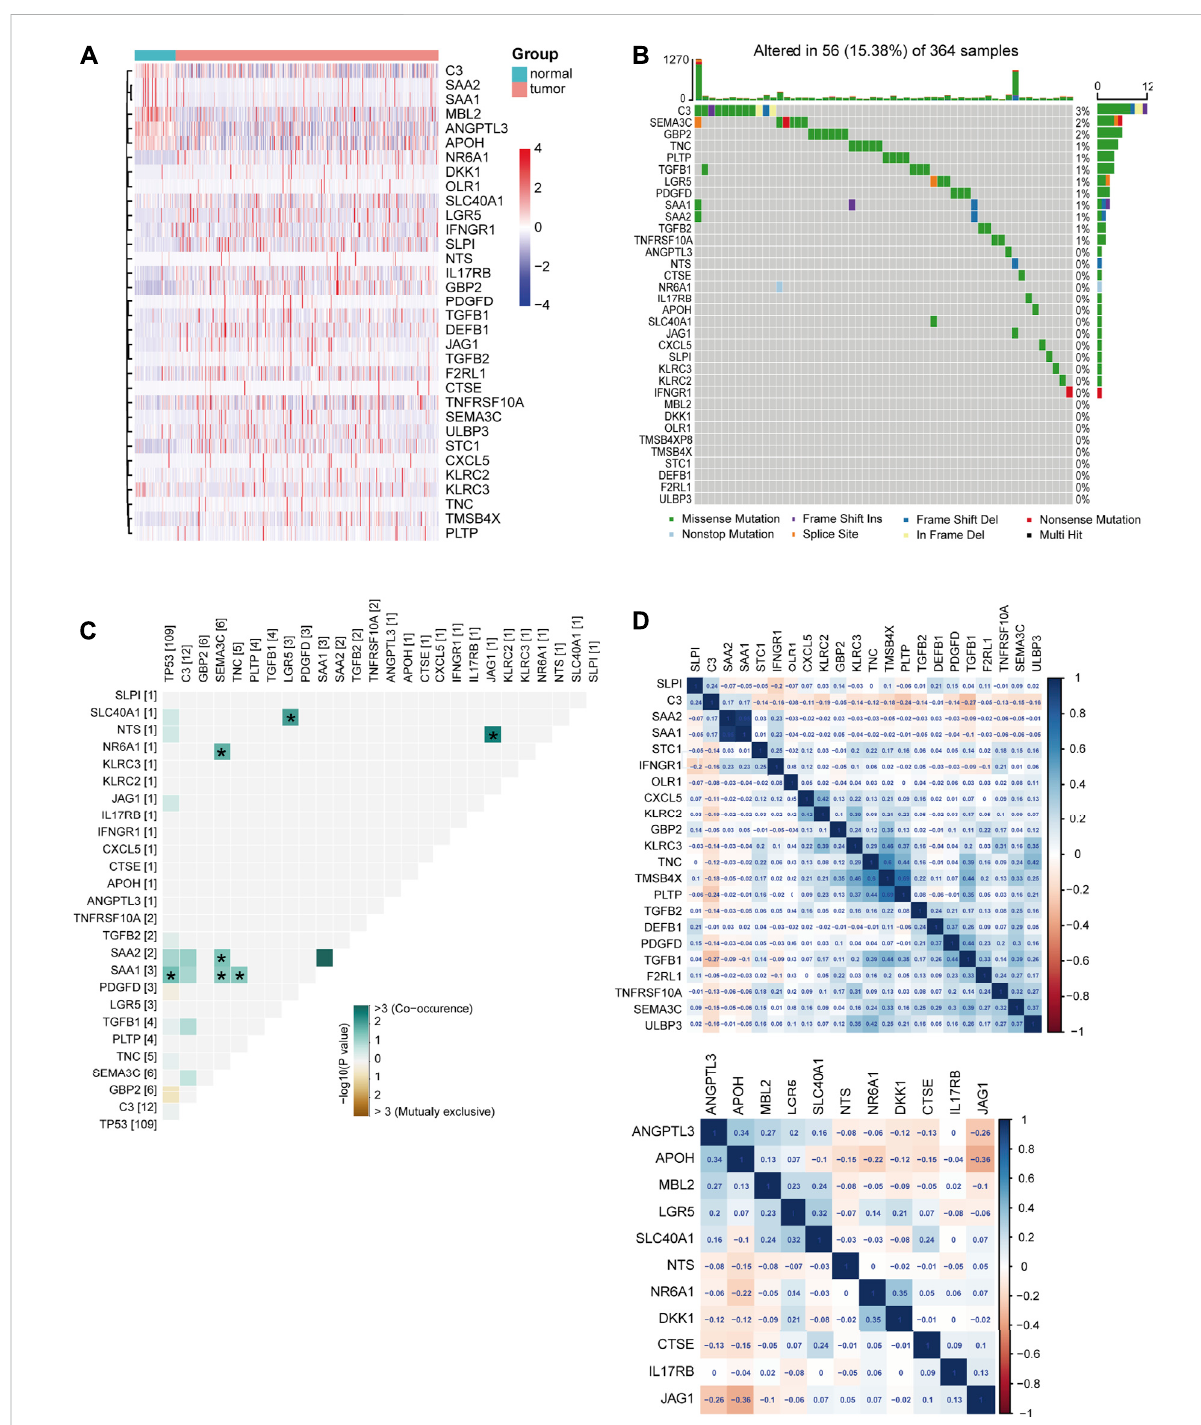
FIGURE 3 Signature of DEIRGs in TCGA-LIHC. (A) Expression heatmap of DEIRGs between normal and LIHC patients in TCGA. (B) Mutation status of DEIRGs. (C) Correlation between mutation status of DEIRGs and TP53 . (D) Expression correlation between DEIRGs. Upper, upregulated DEIRGs; below, downregulated